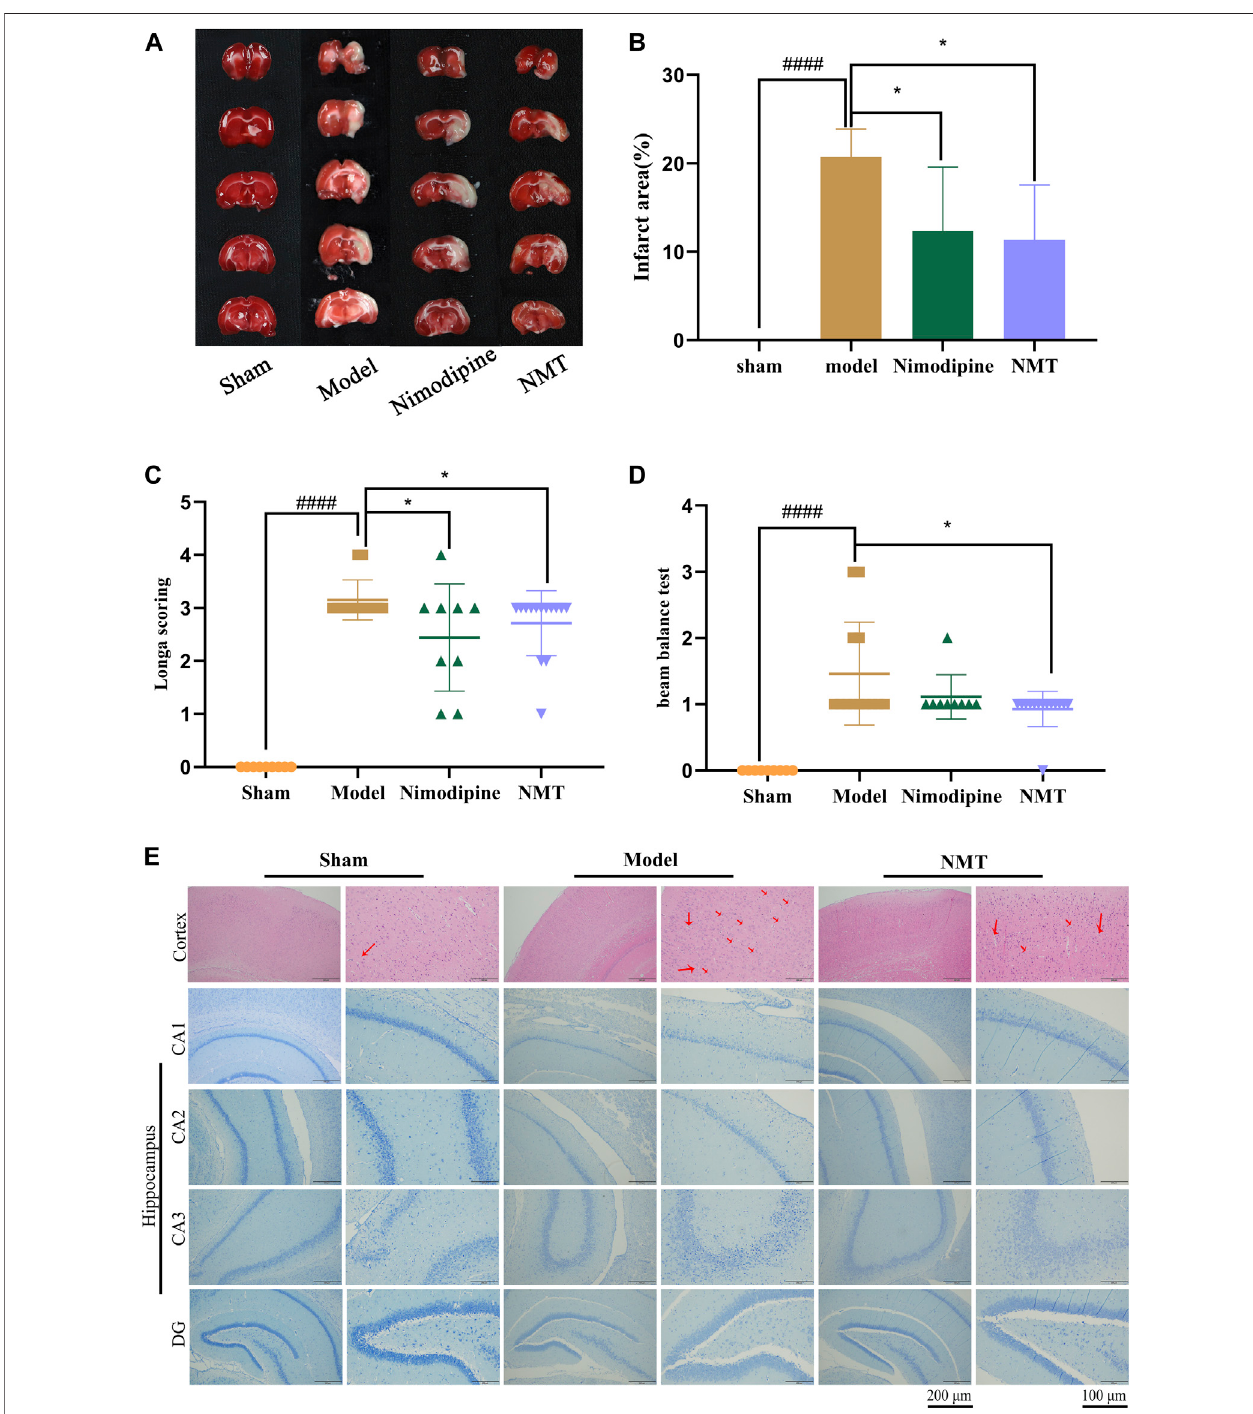
FIGURE 1 | NMT improved neurological function and infarct area in post-stroke restoration. (A) TTC staining. (B) Cerebral infarct area percentage ( n (cid:1) 6). Comparedwithshamgroup,statisticalsigni fi cancewasconsideredat## p < 0.01,### p < 0.001forallthetest;Comparedwithmodelgroup,statisticalsigni fi cancewas considered at * p < 0.05, ** p < 0.01 and *** p < 0.001 for all the tests. (C) Neurological score ( n (cid:1) 9). (D) Beam balance test ( n (cid:1) 9). Throughout, error bars represent mean ± SD. (E) H&E Staining of cerebral cortex and Nissl ’ s staining of cerebral hippocampus difference partition such as CA1, CA2, CA3, DG. The red arrows represent apoptotic neurons. (Scales bar (cid:1) 200 and 100 μ m n (cid:1) 4).